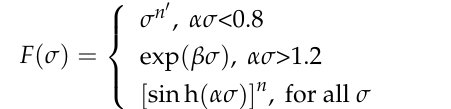
According to Equation (13), the values of n and A can be obtained from the relationship between lnZ and ln[sinh ( ασ )], as shown in Figure